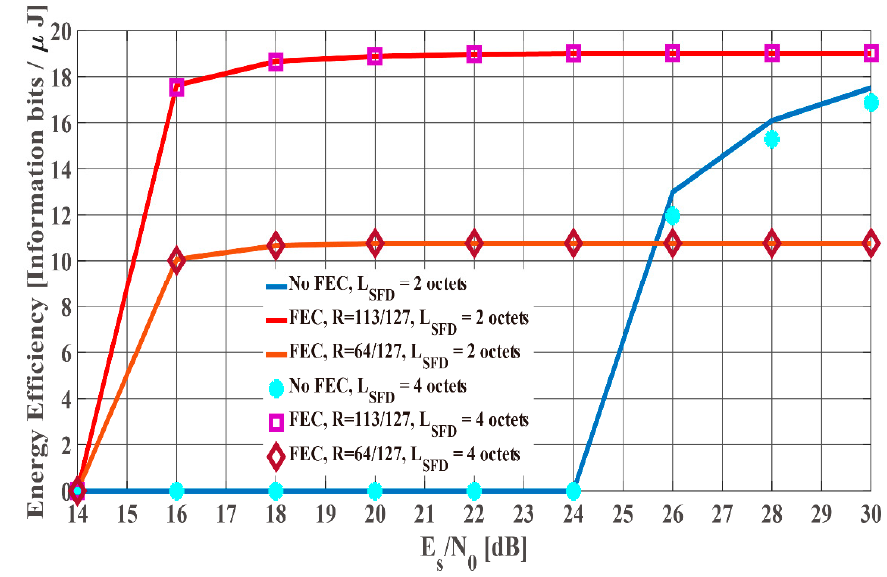
Figure 22. The maximum energy efficiency under the IEEE model CM3 as a function of E s / N 0 .